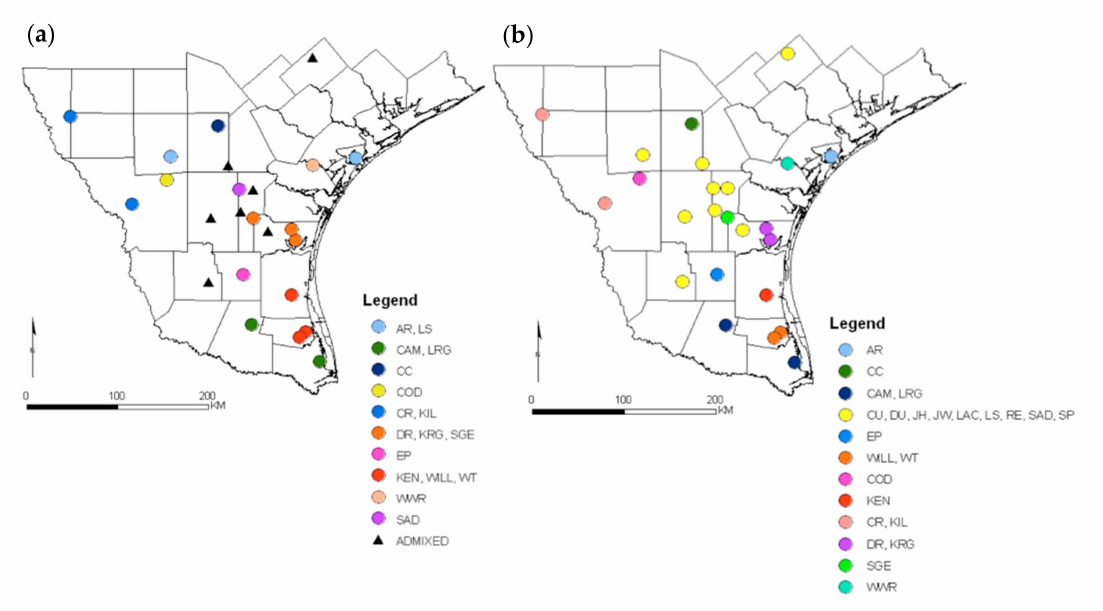
Figure 3. Geographic distribution of genetic clusters based on the best partition generated in the Bayesian clustering algorithm, Structure 2.2 ( a ) (assuming K = 10) and in the Bayesian spatial clustering algorithm BAPS 4.2 ( b ) (assuming K = 12) from wild pigs collected in 24 sites during 2005–2009 in southern Texas,